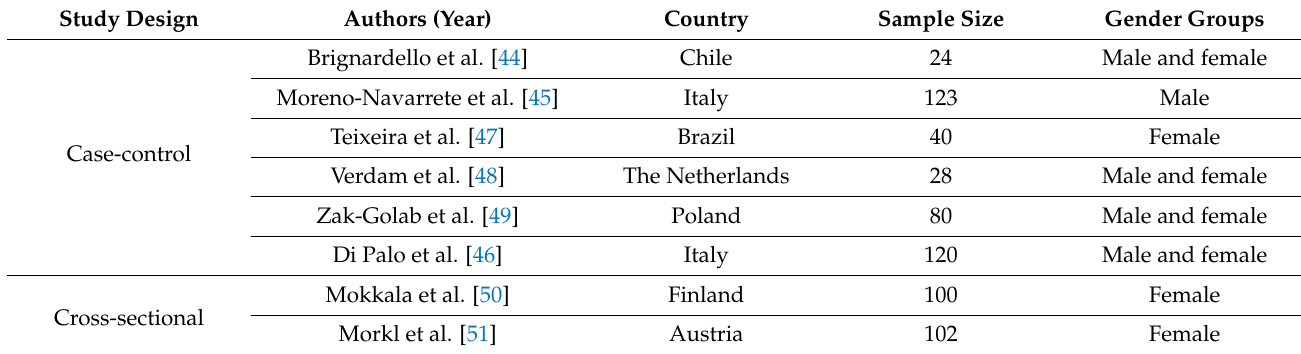
Table 1. Characteristics of the studies included in this systematic review.